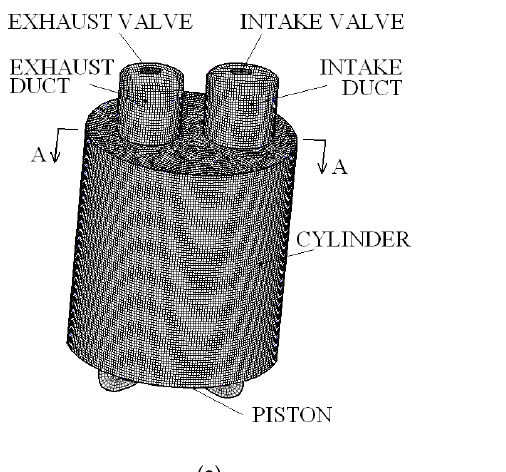
Figure 2. Piston head of the engine studied in the present work.